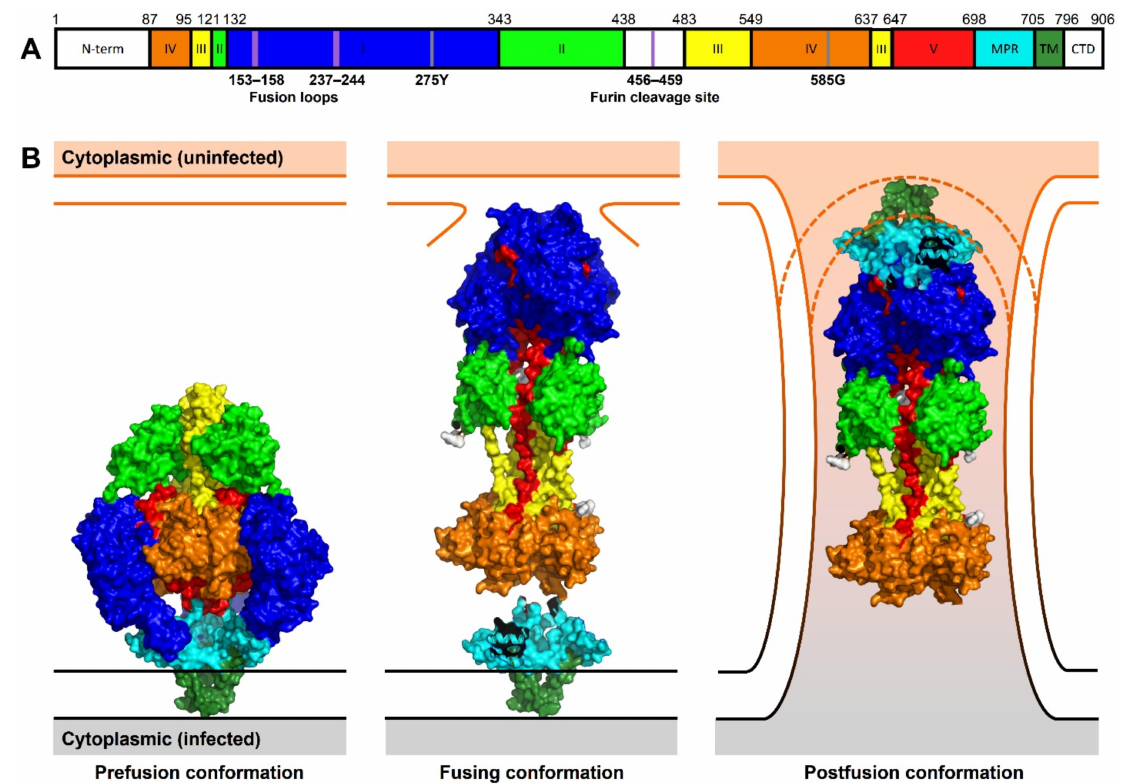
Figure 2. Linear representation and structural conformations of HCMV gB. ( A ) Distribution of HCMV gB structural domains within the gB primary domain. Amino acid indices at the domain boundaries are indicated above the sequence representation. Fusion loops and furin cleavage site are indicated as violet lines. Two known residues that effect HCMV gB fusion activity are marked as grey lines. ( B ) gB protein structures indicating conformations during the stages of cell–cell fusion. The prefusion conformation (PDB 7KDP) is compressed on the infected cell membrane. During cell–cell fusion, gB extends to bind to an additional uninfected cell membrane. The fusing conformation (PDB 5CXF) is modeled with the MPR-TM domain (PDB 7KDP) modeled by protein alignment to the conserved IV domain. In the postfusion conformation, gB (PDB 5CFX) is modeled with the MPR-TM domain (PDB 7KDP) as shown in [92]. 2021. The surface representation has been generated using PyMOL and the structural domains are mapped and color-coded as described [90,92]: N-terminal signaling sequence (N-term) and cytoplasmic domain (CTD) in white; domain I = blue, II = green, III = yellow, IV = orange, V = red; membrane proximal region (MPR) in cyan, and transmembrane region (TM) in dark